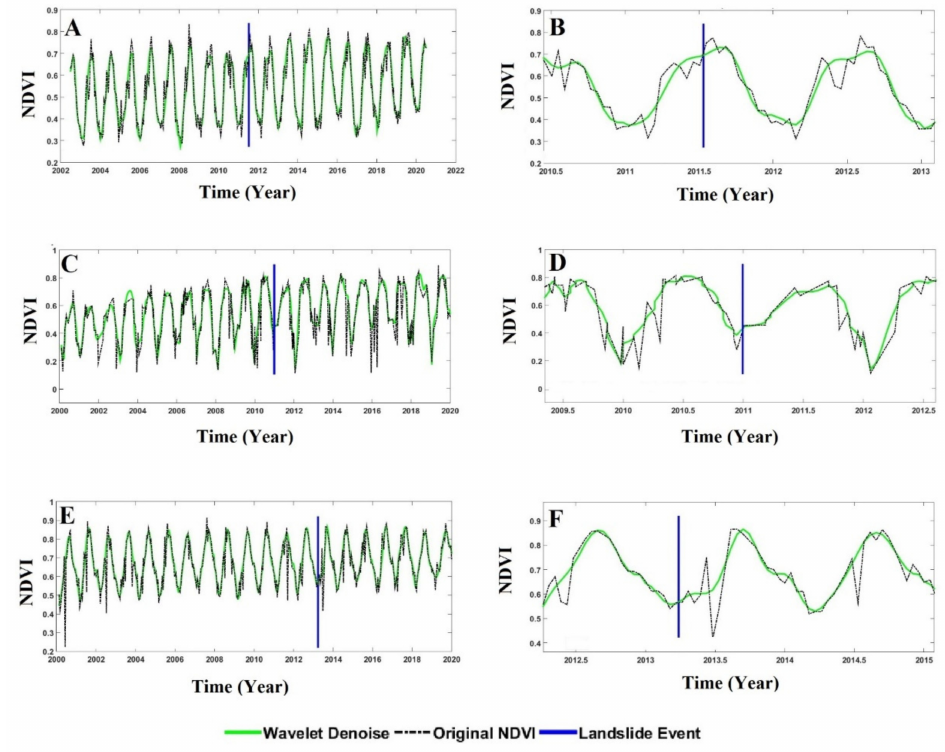
Figure 7. Timing of landslide event occurrences (vertical blue line) on denoised NDVI time series (MYD, ETM+, MOD). ( A ) NDVI from MYD with the landslide event of 13 July 2011 (China, longitude: 101.0144 ◦ E, latitude: 30.0315 ◦ N) and its zoom ( B ); ( C ) NDVI from ETM+ with the landslide event of 30 December 2010 (Nepal, latitude: 29.7415 ◦ N, longitude: 81.2467 ◦ E) and its zoom ( D ); ( E ) NDVI from MOD with the landslide event of 29 Mar 2013 (China, latitude: 30.0315 ◦ N, longitude: 101.0144 ◦ E) and its zoom ( F